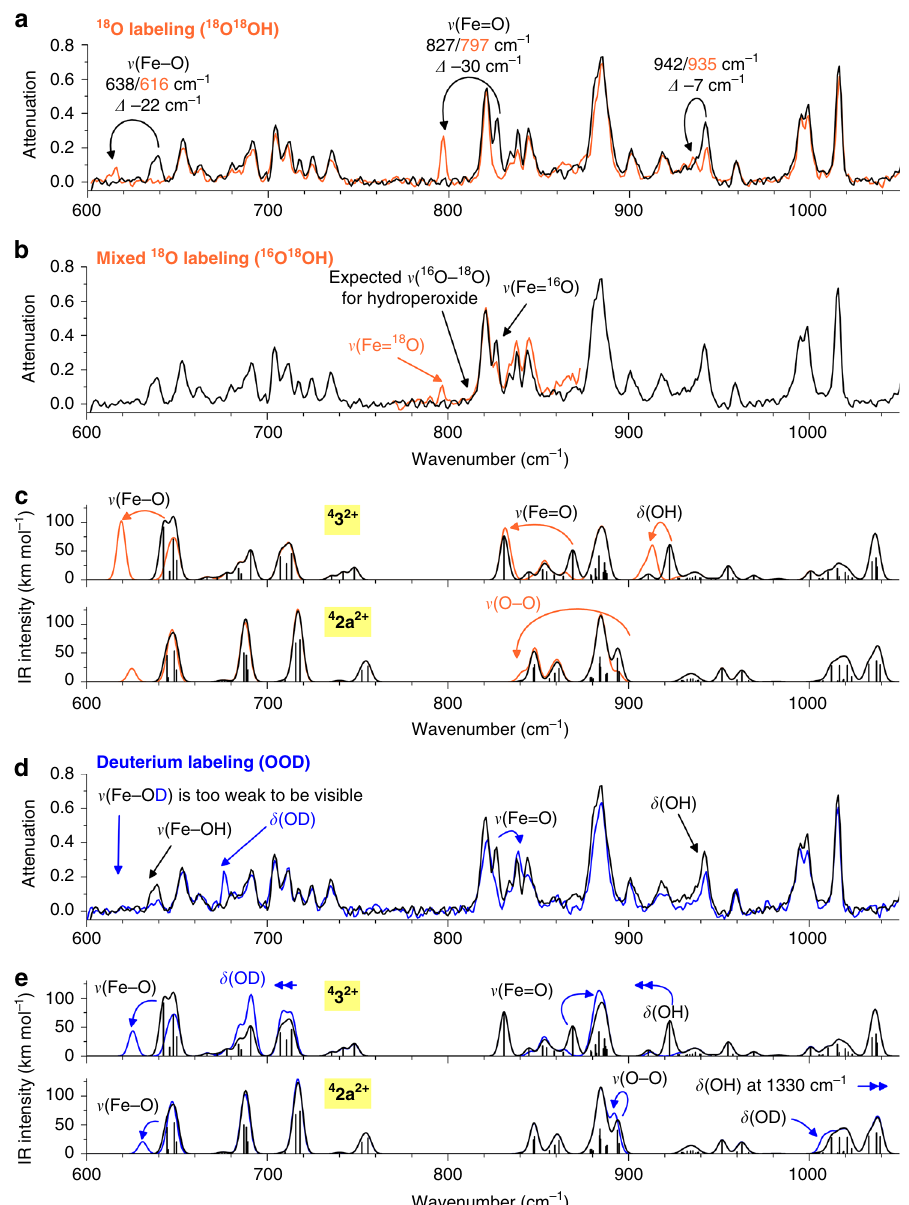
Fig. 3 IRPD spectrum of the ions generated from the reaction mixture of 1 with H 2 O 2 and their prediction. a IRPD spectra of 3 2 + (black trace) and 3 2 + ( 18 O 18 O) (orange trace). b IRPD spectra of 3 2 + and 3 2 + ( 18 O 16 O). c B3LYP-D3/def2TZVP predictions of the IR spectra for the 3 2 + and 2a 2 + complexes. d IRPD spectra of 3 2 + and 3 2 + ( 2 H). e B3LYP-D3/def2TZVP predictions of the IR spectra of 3 2 + and 2a 2 +